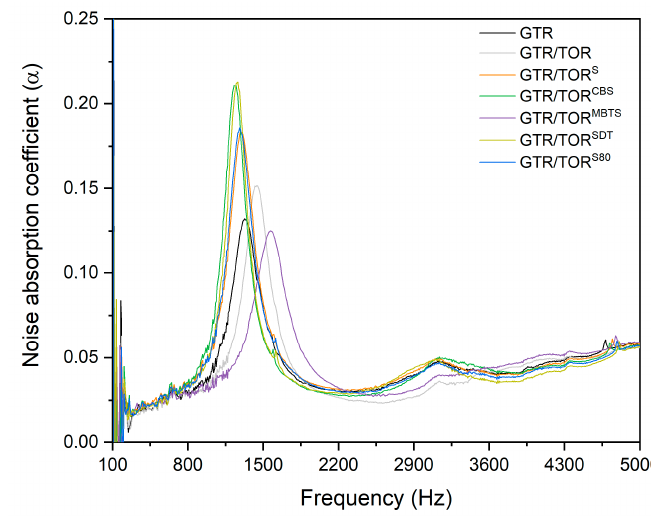
Figure 7. Sound absorption coefficient as a function of frequency.